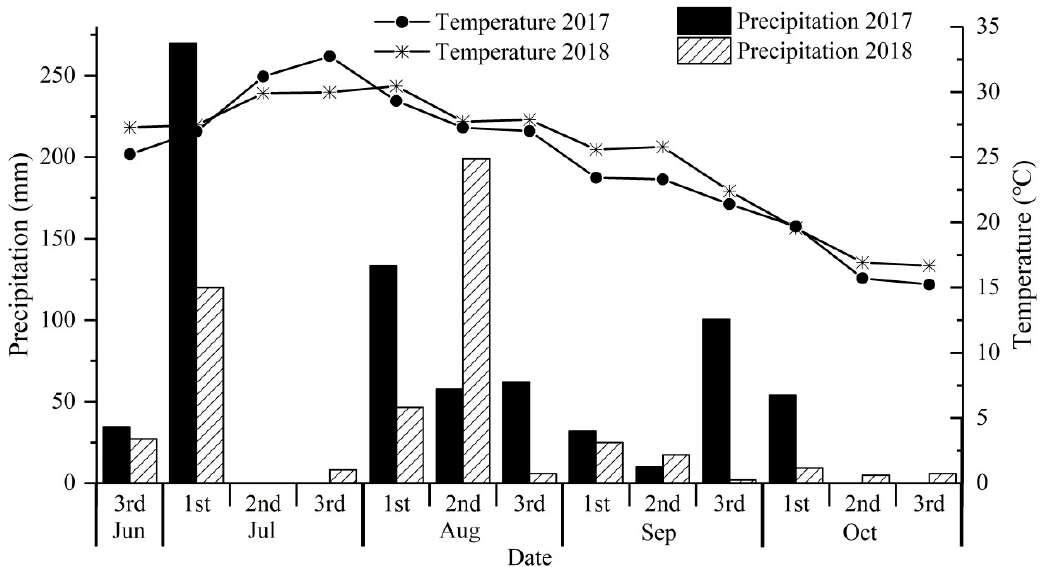
Figure 2. The temperature and precipitation during the rice growth stage in 2017 and 2018.